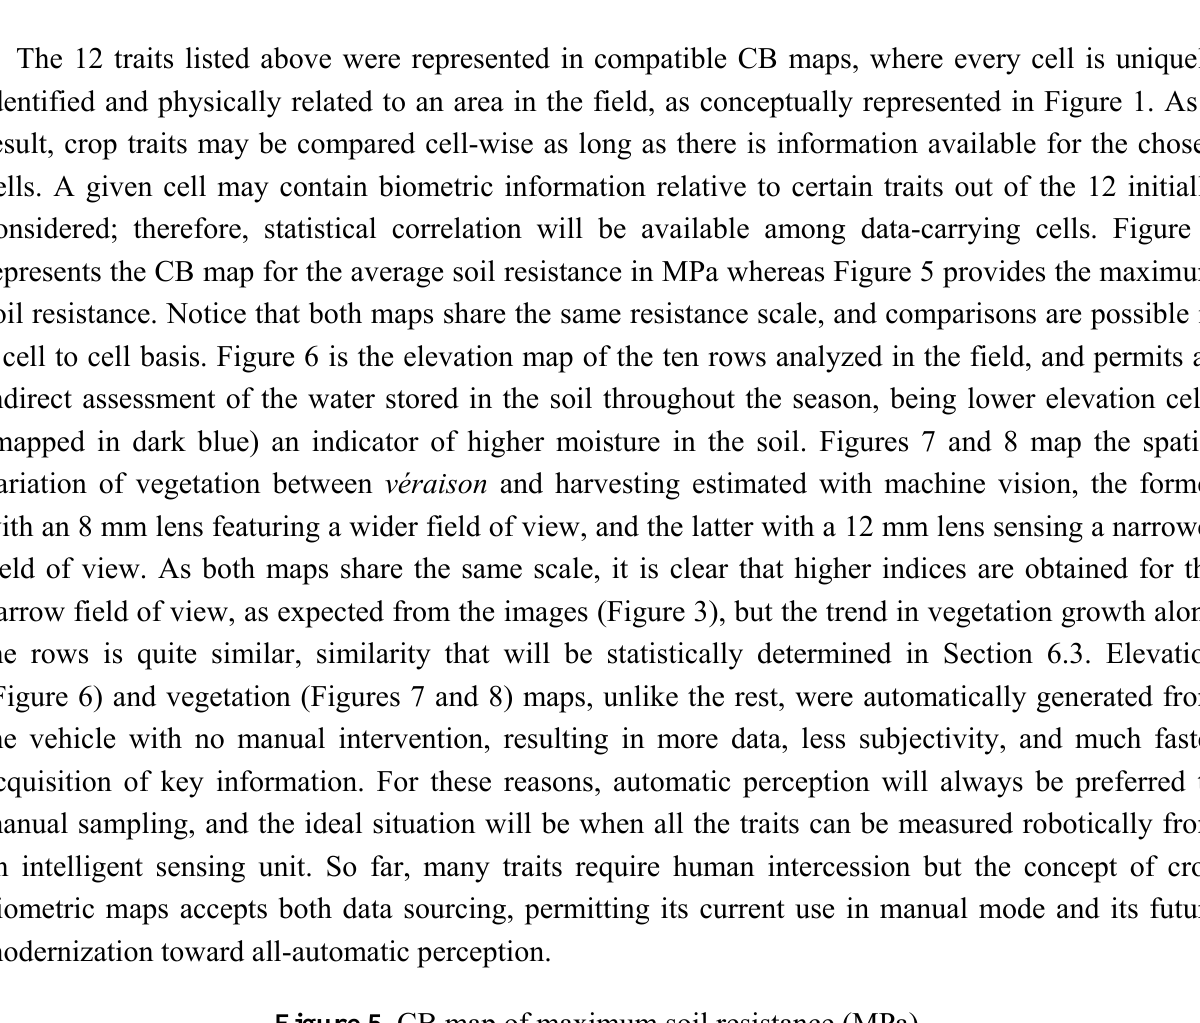
Figure 5. CB map of maximum soil resistance